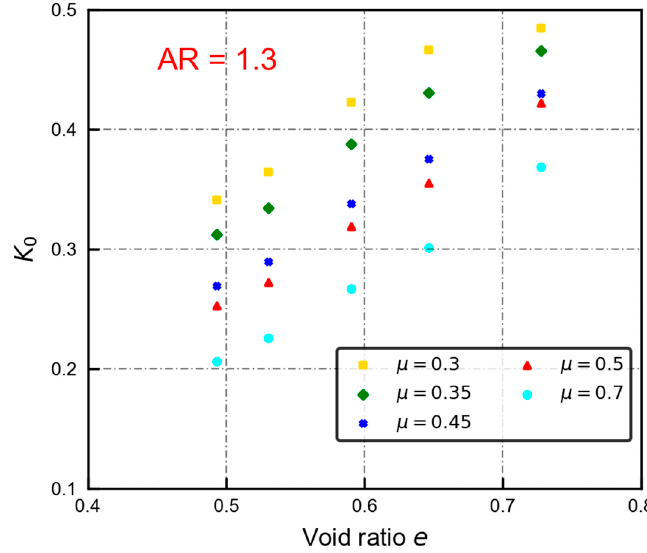
Figure 13. K 0 versus initial void ratio for specimens with different μ values.